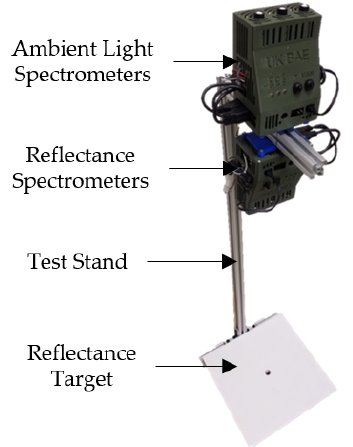
Figure 1. Spectral measurement systems consisting of three ambient light spectrometers and three